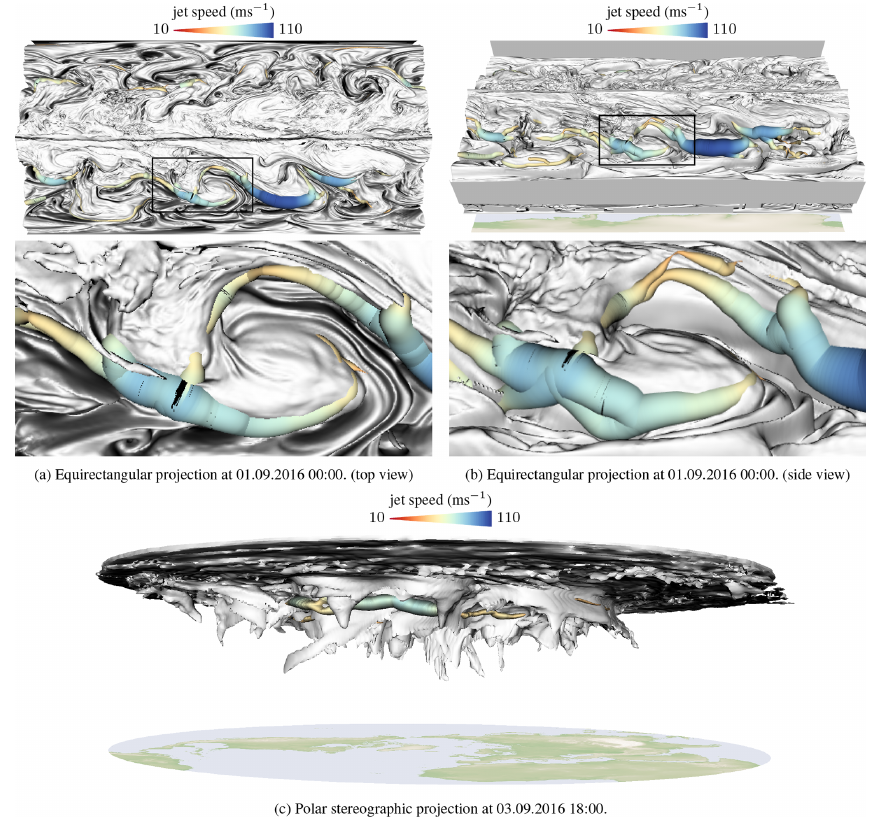
Figure 11. Interaction of jet stream and tropopause. The jet stream is located where the tropopause is steep. Jet speed is mapped to tube color and tube